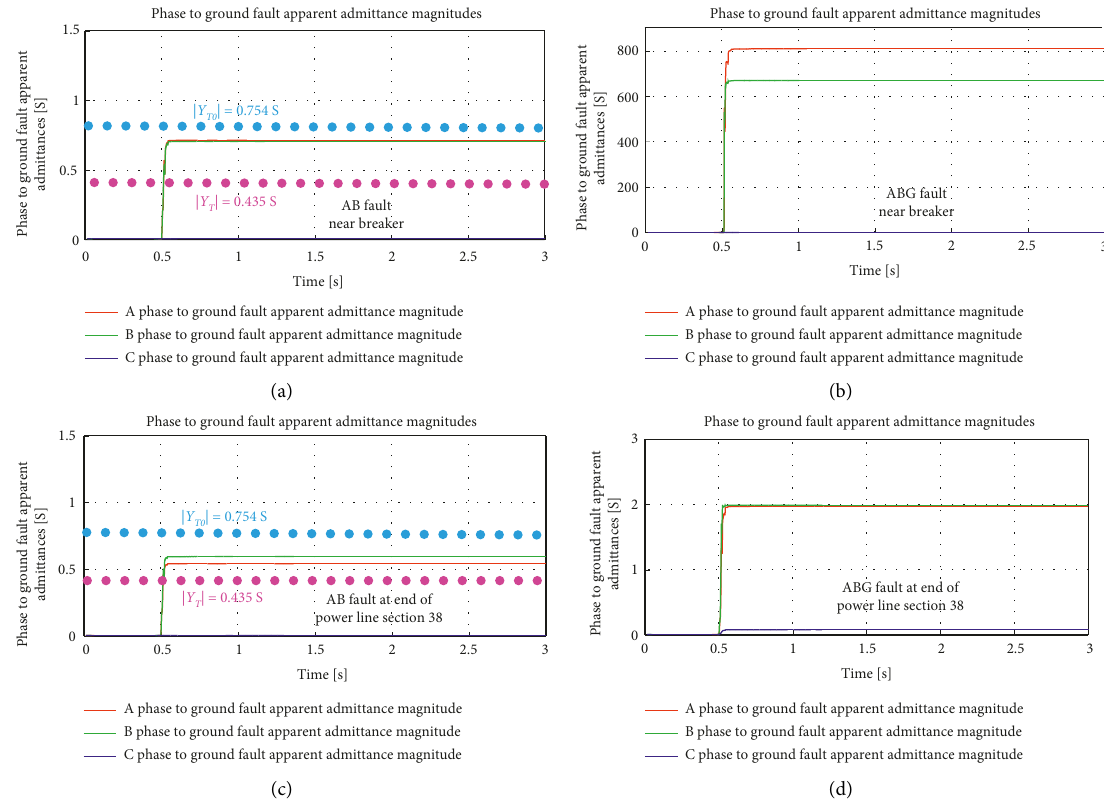
Figure 13: Measured PGFA admittance magnitudes for the grid simulated AB and ABG electrical faults (a, b) near breaker and (c, d) end of the power line section 38 with the CT/PT saturated